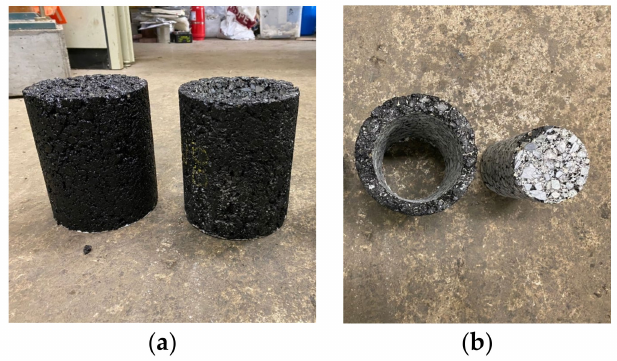
Figure 3. Fabrication of specimens: ( a ) primary specimens and ( b ) final specimens.